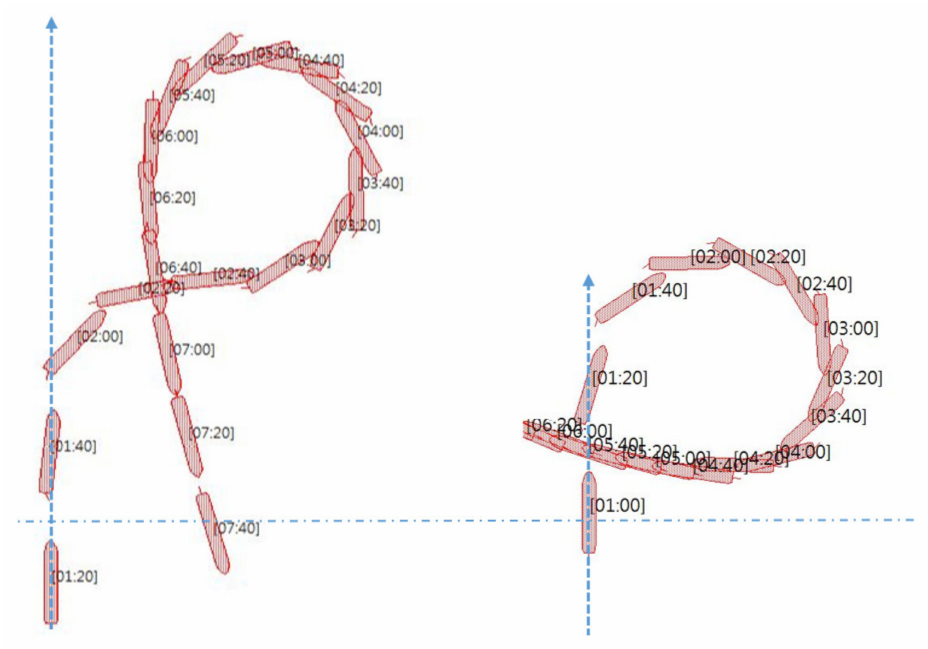
Figure 6. Williamson turn ( left ), Anderson turn ( right ).